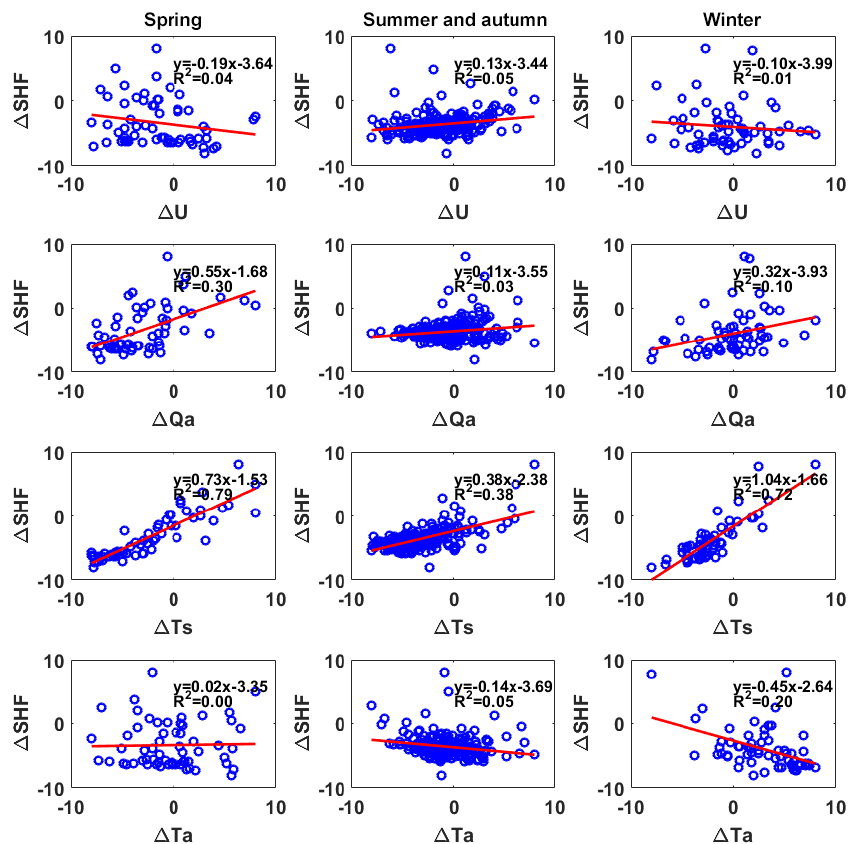
Figure 11. Same as Fig. 9 but for the biases in